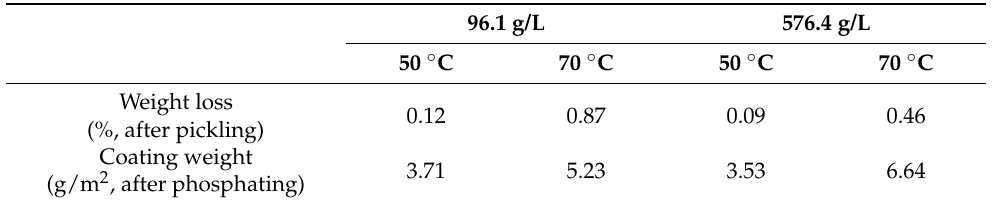
Table 7. Weight loss (%) after the pickling with citric acid and coating weights (g/m 2 ) of the phosphate developed